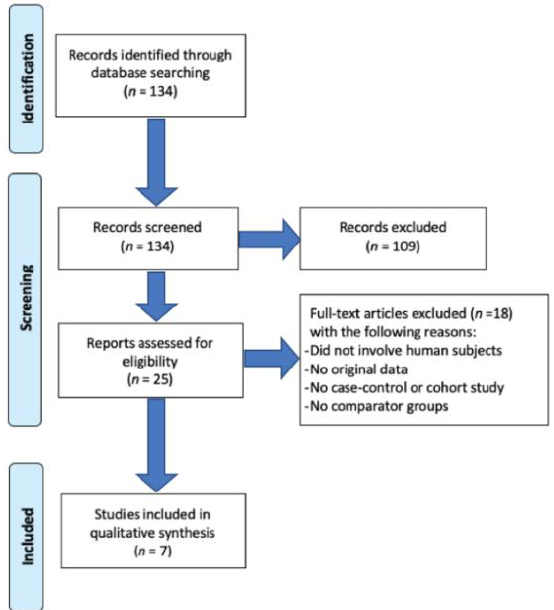
Figure 1. Flow diagram.